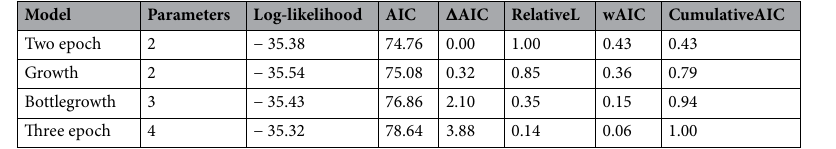
Table 4. Demographic models ranked by AIC scores.